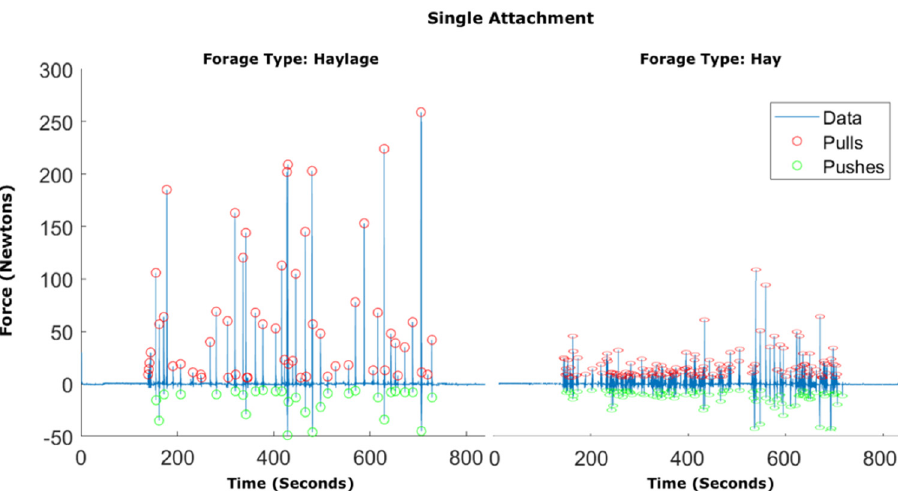
Figure 13. Pressure readings following MATLAB data extraction for one horse eating either haylage ( left ) or hay ( right ) from a single haynet under the single attachment variable.